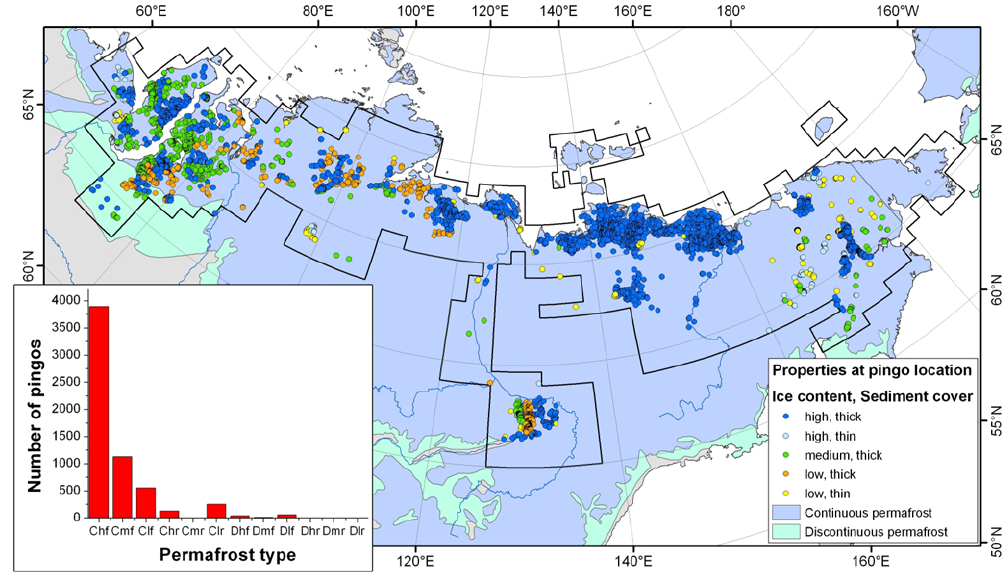
Fig. 9. Pingo distribution by permafrost type, ground ice content, and sediment thickness (based on Brown et al., 1998). (Permafrost type: C